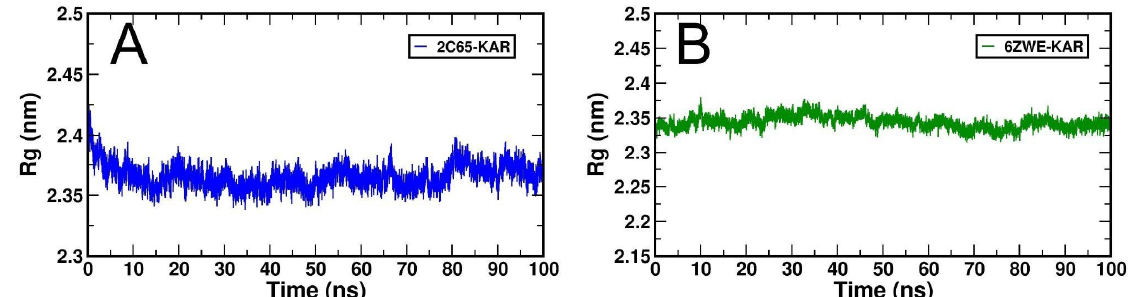
Figure 8. Generated Rg plots for both docking complexes from MD simulation at 100 ns. ( A ), Rg plot of 2C65-KAR and ( B ), Rg plot of 6ZWE-KAR. Similarly, the SASA plots indicated the compactness of in form of native constant of the target protein after interaction with an inhibitor mainly hydrophobic interaction.